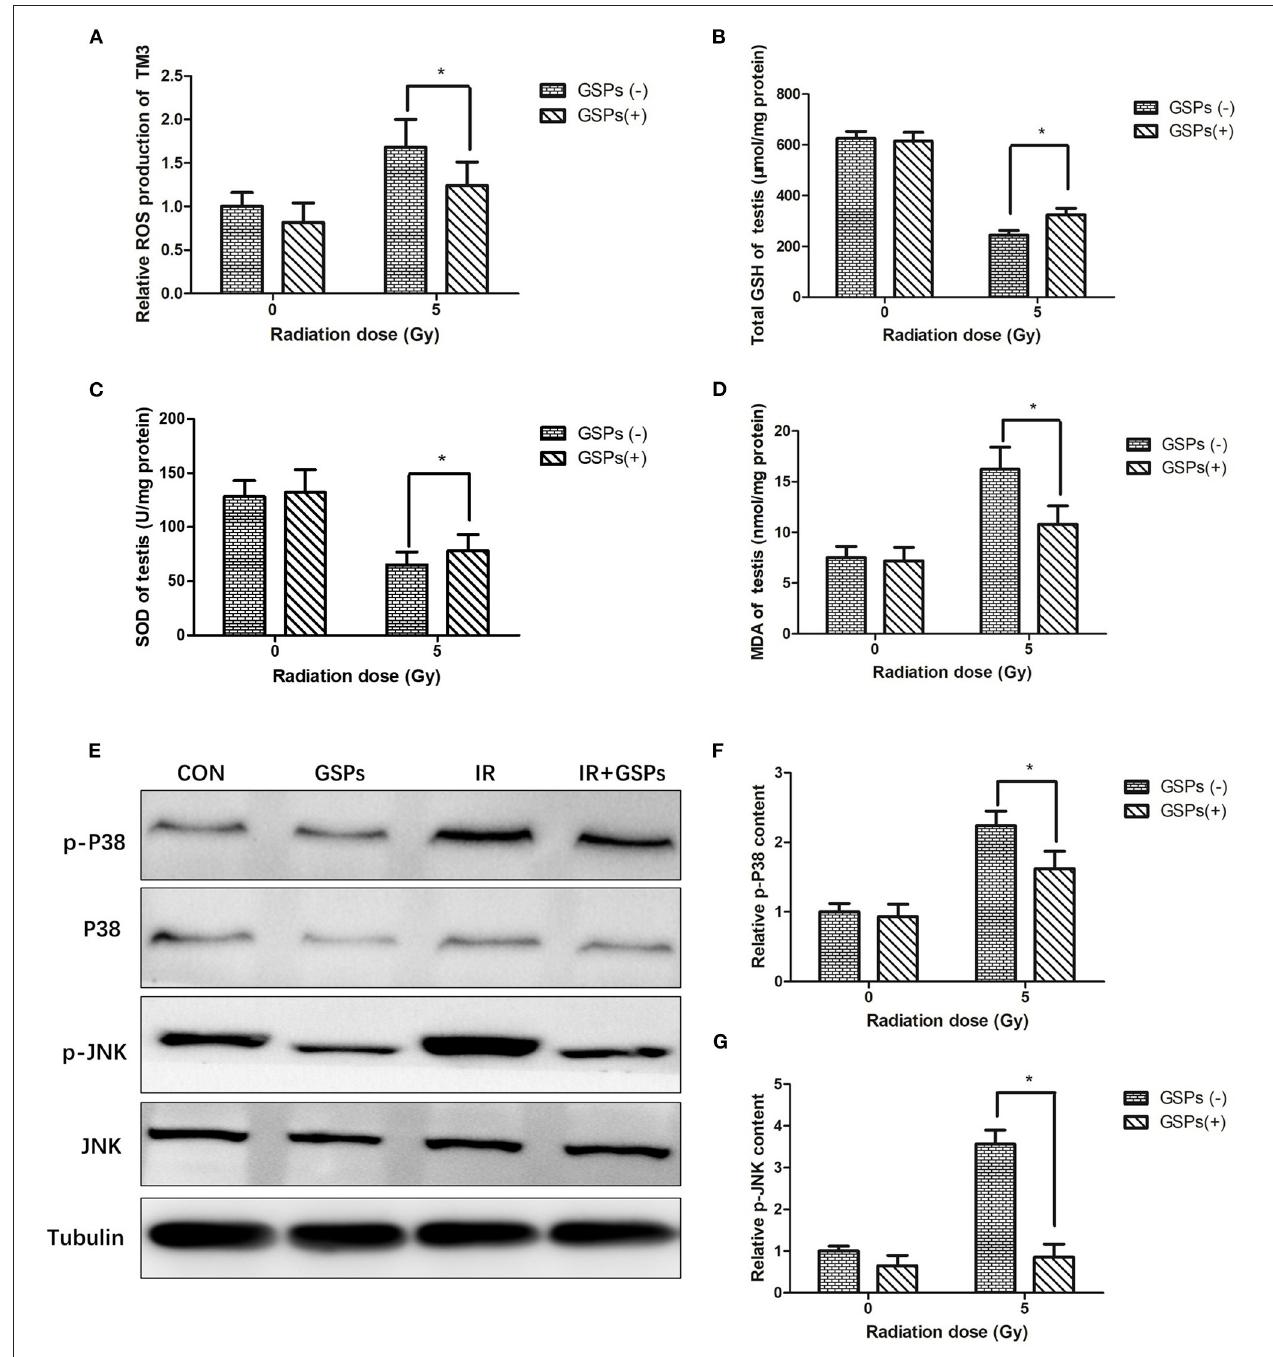
FIGURE 5 | Grape seed proanthocyanidins play a radioprotective effect in testes through antioxidant effects and inhibition of MAPK signaling pathways. (A) The increase of intracellular ROS of TM3 cells induced by IR is significantly suppressed by GSPs. The content of total GSH (B) and SOD (C) in the testes decrease by IR, and the content of MDA (D) increases, while GSPs alleviate these changes. (E) The expression of p-P38 and p-JNK is significantly increased in irradiated testes, while GSPs lower the increase. (F) Quantitative analysis of relative p-P38 content. (G) Quantitative analysis of relative p-JNK content. Data are presented as mean ± SD ( n = 3). * P <